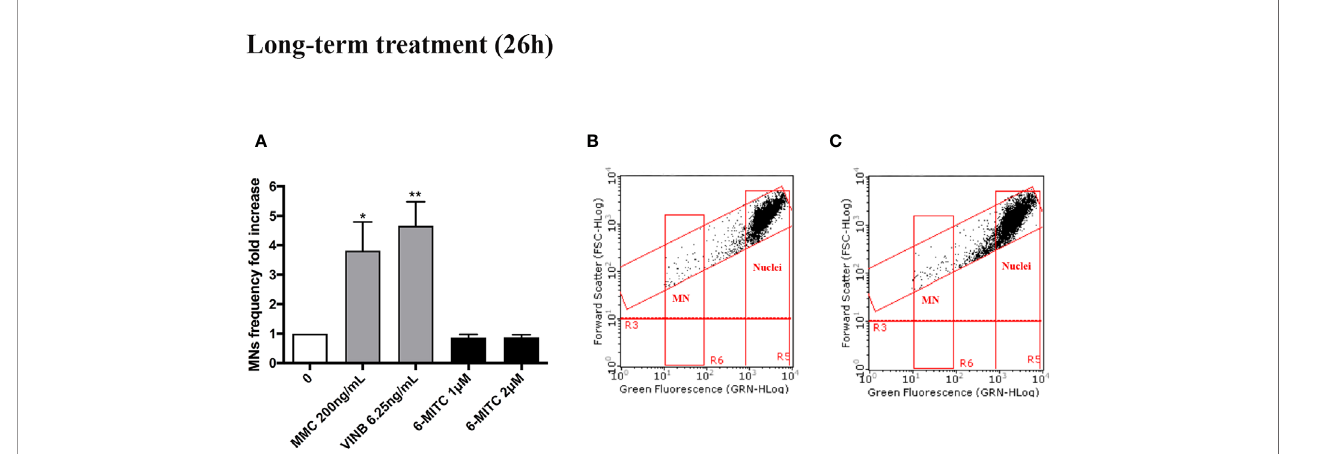
FIGURE 7 | Effect of 6-MITC on mutagenesis after long term treatment. MNs frequency fold increase (A) and dot plot obtained by FCM in the control cultures (B) and 6-MITC 2 µM treatment cultures (C) on TK6 cells after 26h of treatment. Each bar represents the mean ± SEM of fi ve independent experiments. Data were analysed using repeated ANOVA followed by Bonferroni post-test. *p < 0.05 vs 0; **P < 0.01 vs